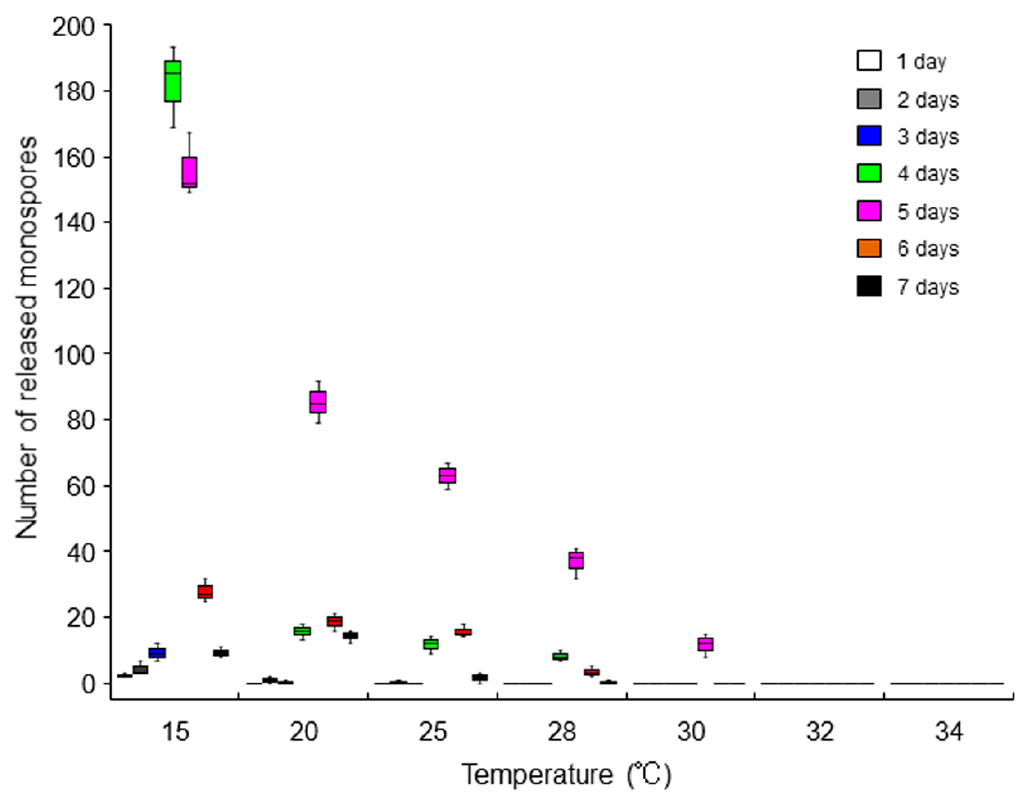
Figure 5. Effects of the heat stress on asexual propagation in ‘ Bangia ’ sp. ESS2. Release of asexual spores from thalli (0.02 g) cultured statically at l5, 20, 25, 28, 30, 32, and 34 °C was counted every day for 7 days. Error bars indicate the standard deviation of triplicate experiments ( N = 3).